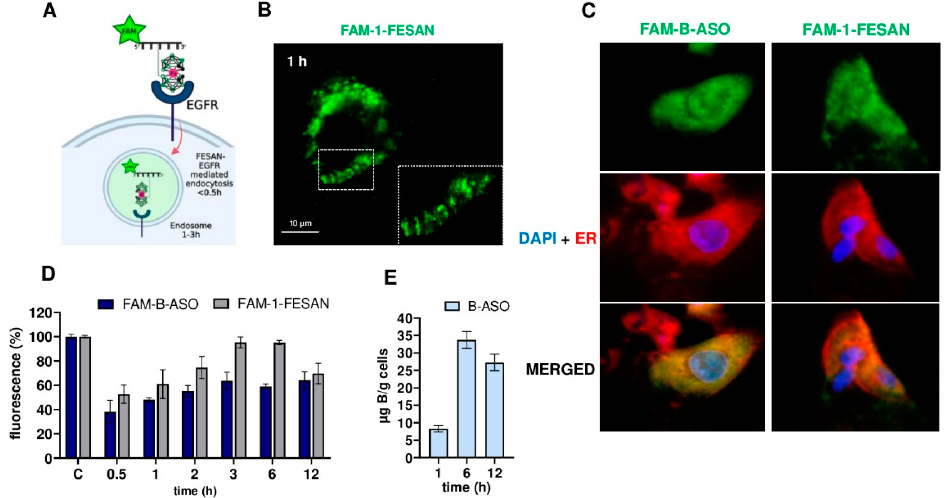
Figure 5. Design concept based on free uptake of FAM-1-FESAN mediated by FESAN-EGFR in A431 cells ( A ). The compound FAM-1-FESAN (80 pmol/well; 1 h incubation) is freely taken up by A431 cancer cells in vitro, as demonstrated using fluorescence microscopy; (n = 3) ( B ). Evaluation FAM-B-ASO and FAM-1-FESAN (80 pmol/well, 12 h incubation) localization in A431 cells using fluorescence microscopy. Visualization of green FAM-B-ASO (row 1) or FAM-1-FESAN (row 2) compounds, blue nuclei (DAPI), and red ER membranes (ER-Tracker Red) are shown. Merged fluorescence images of the FAM-B-ASO or FAM-1-FESAN, nuclei, and ER are shown in row 3; (n = 3). All panels were magnified 60 × ( C ). The time course experiment measured the free uptake of FAM-B-ASO and FAM-1-FESAN (80 pmol/well; incubation time: 0.5, 1, 3, 6, 12 h) using a fluorescence microplate reader. FAM-B-ASO and FAM-1-FESAN (80 pmol/well) and itself without cells are a (C- control). The means ± SEM (n = 3) are shown ( D ). Boron concentration in lysates of A431 cells measured by ICP MS during the time course experiment after 1, 6, and 12 h of incubation with B-ASOs (80 pmol/well). The means ± SEM (n = 3) are shown ( E ). Figures were created in BioRender (https://biorender.com/, accessed on 23 June 2022) and GraphPad Prism (https://www.Graphpad.com/, accessed on 15 August